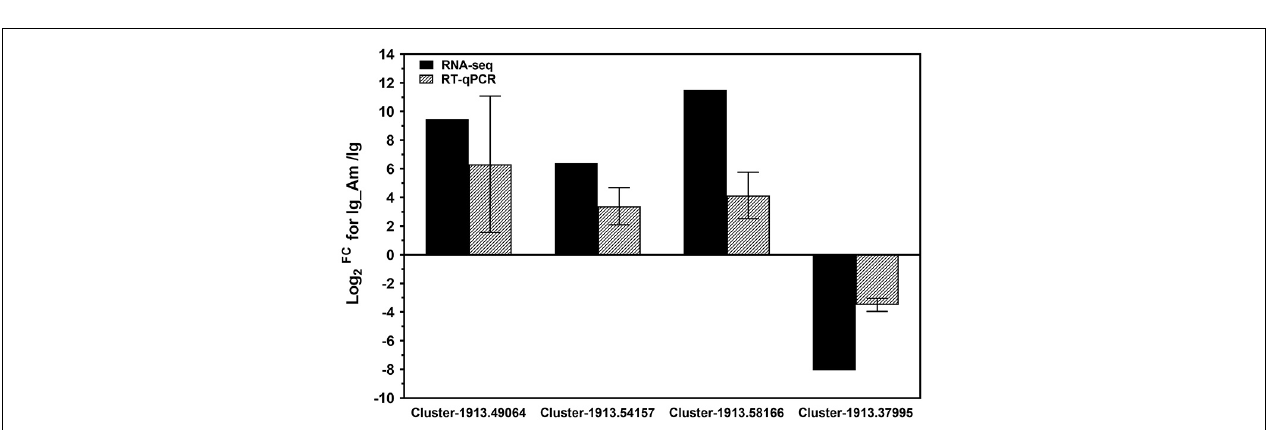
FIGURE 3 | Schematic diagram of transcriptional responses of I. galbana to co-culture with A. macleodii . I. galbana cell in yellow and A. macleodii cell in gray. Red and green arrows indicate the related genes or pathways were up-regulated and down-regulated, respectively. Log 2 foldchange in comparison group Ig_Am/Ig for the expression of the related genes and the gene names were denoted with the white dotted box.